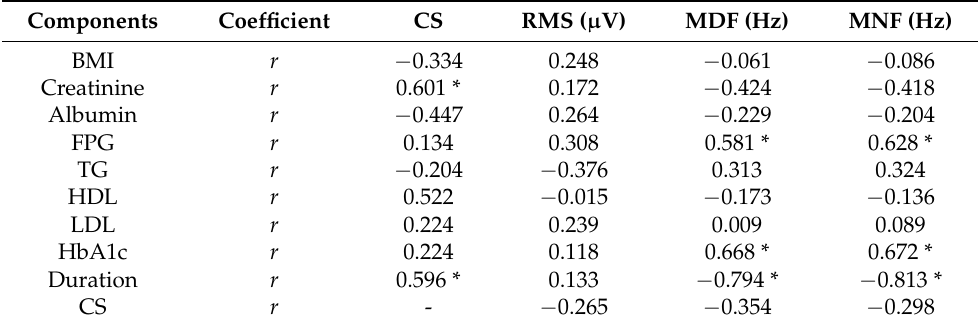
Table 4. Pearson’s correlation coefficient ( r ) between parameters and CS, RMS, MDF, and MNF using Pearson correlation analysis in patients with